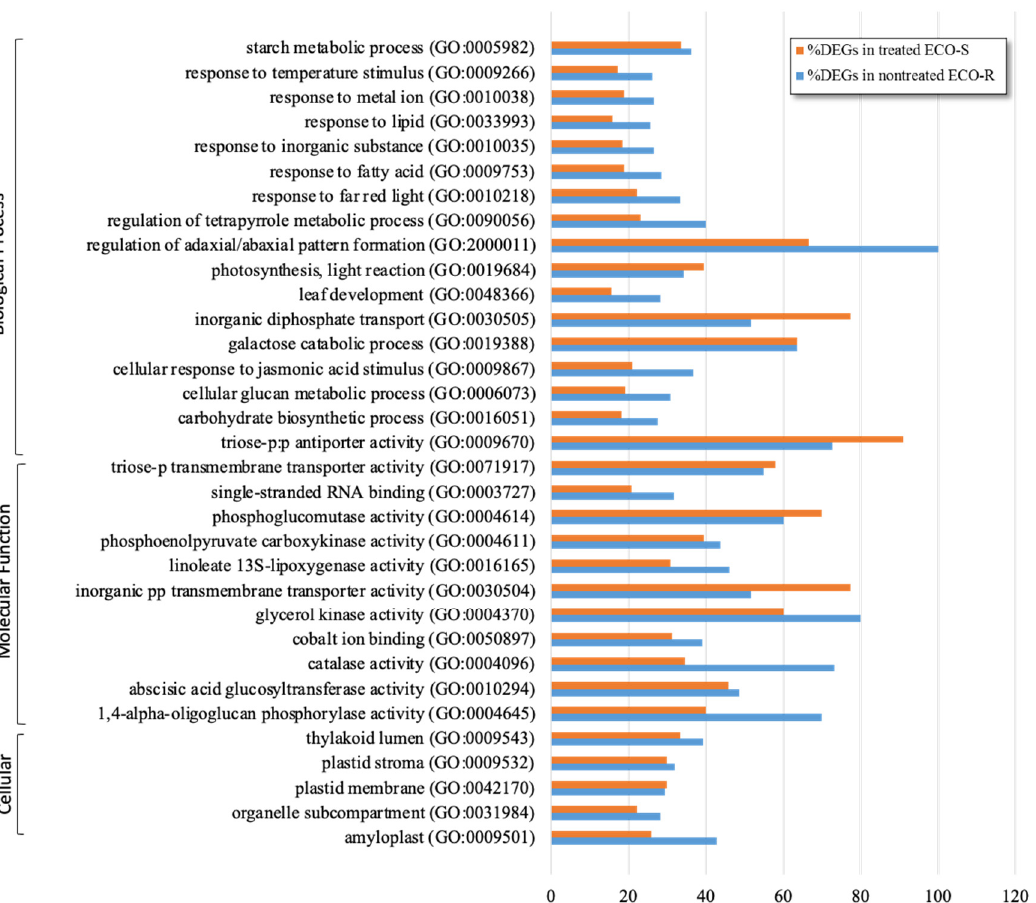
Figure 2. Enrichment of similar GO terms between nontreated quinclorac-resistant (ECO-R) and treated quinclorac-susceptible (ECO-S) Echinochloa colona genotypes. The percentages of differentially expressed genes within each GO term are presented.